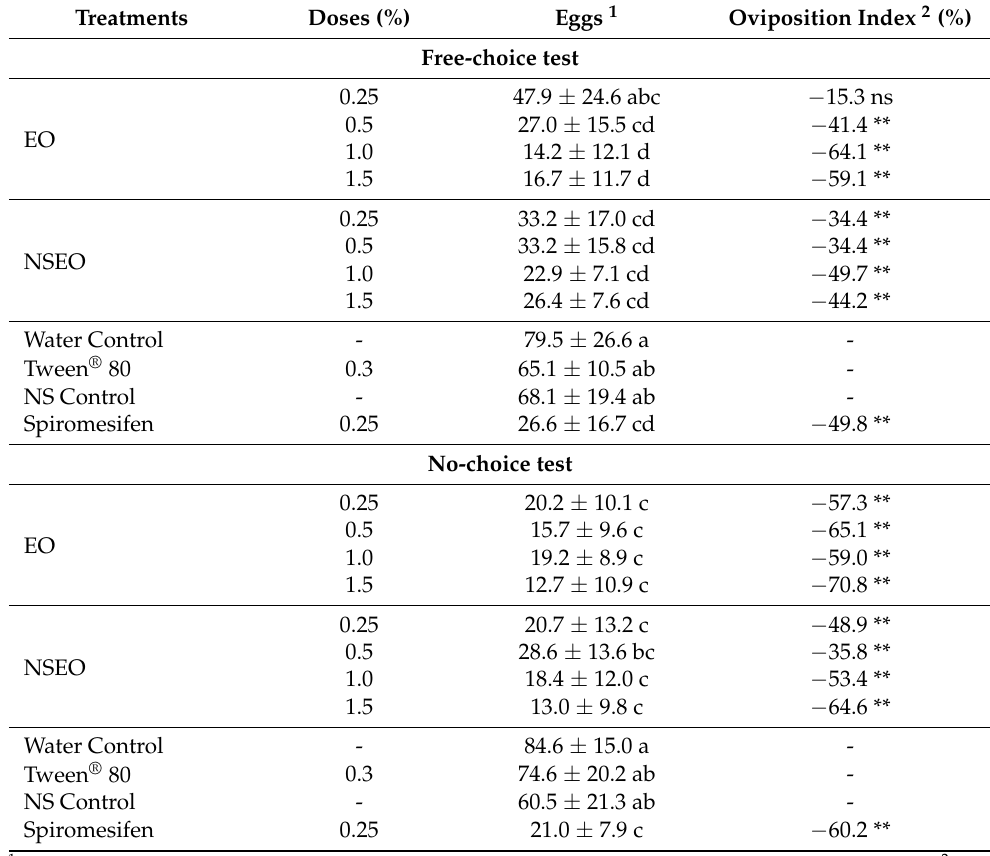
Table 4. Free-choice and no-choice tests comparing B. tabaci oviposition after treatment with essential oil extracts in the free (EO) and nanoencapsulated (NSEO) form of Z. rhoifolium